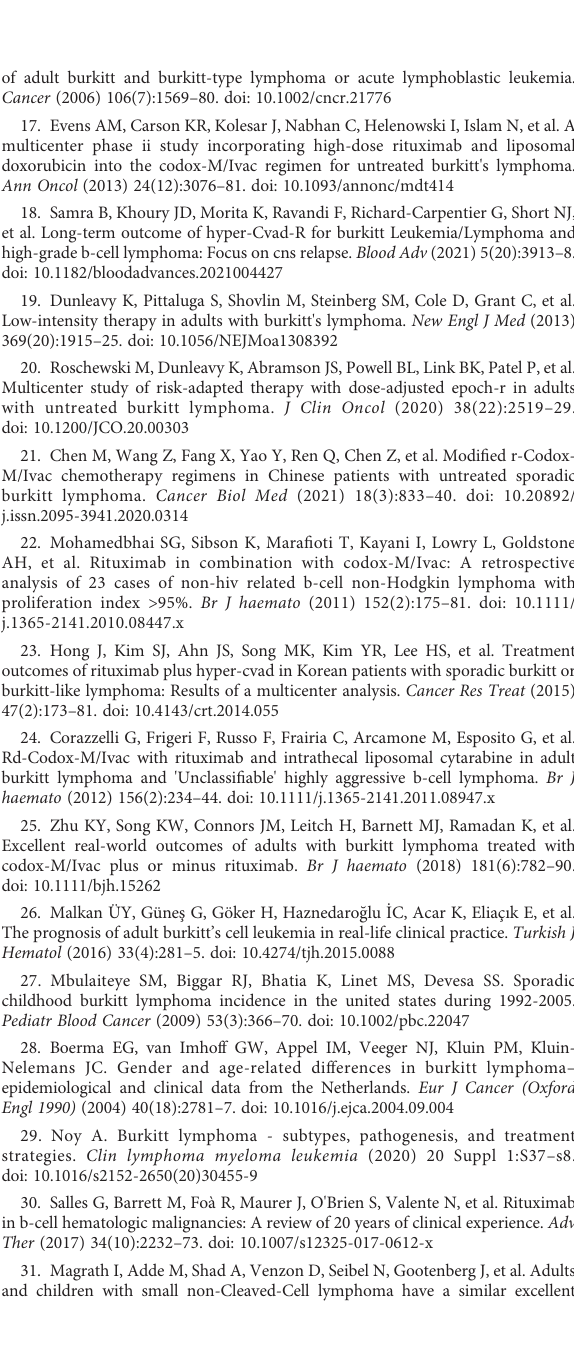
SUPPLEMENTARY FIGURE 1 Pooled ORR according to regimen group SUPPLEMENTARY FIGURE 2 Pooled 2-year PFS rate according to regimen group SUPPLEMENTARY FIGURE 3 Funnel plot of ORR SUPPLEMENTARY FIGURE 4 Funnel plot of 2-year PFS